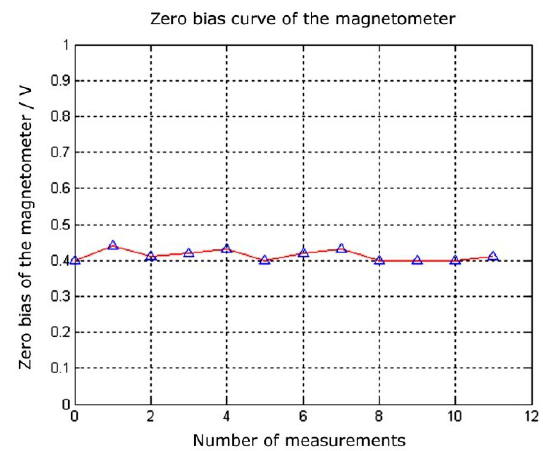
Figure 11. Testing curve for the zero deviations of the prototype.